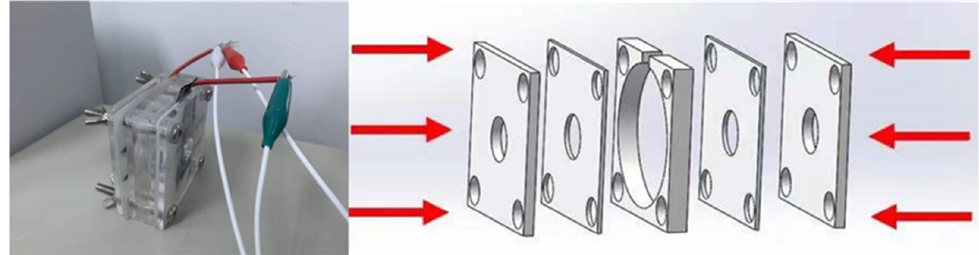
Figure 1. Actual image and schematic diagram of homemade Mg–air primary battery.